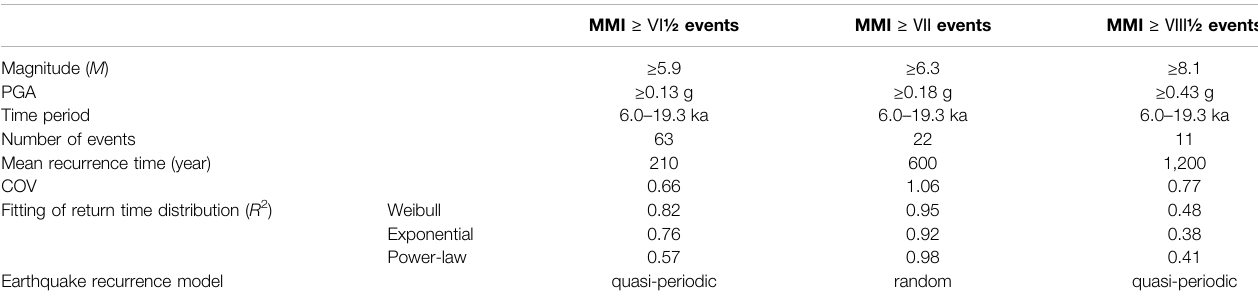
TABLE 2 | Statistical analysis of recurrence times for the referred